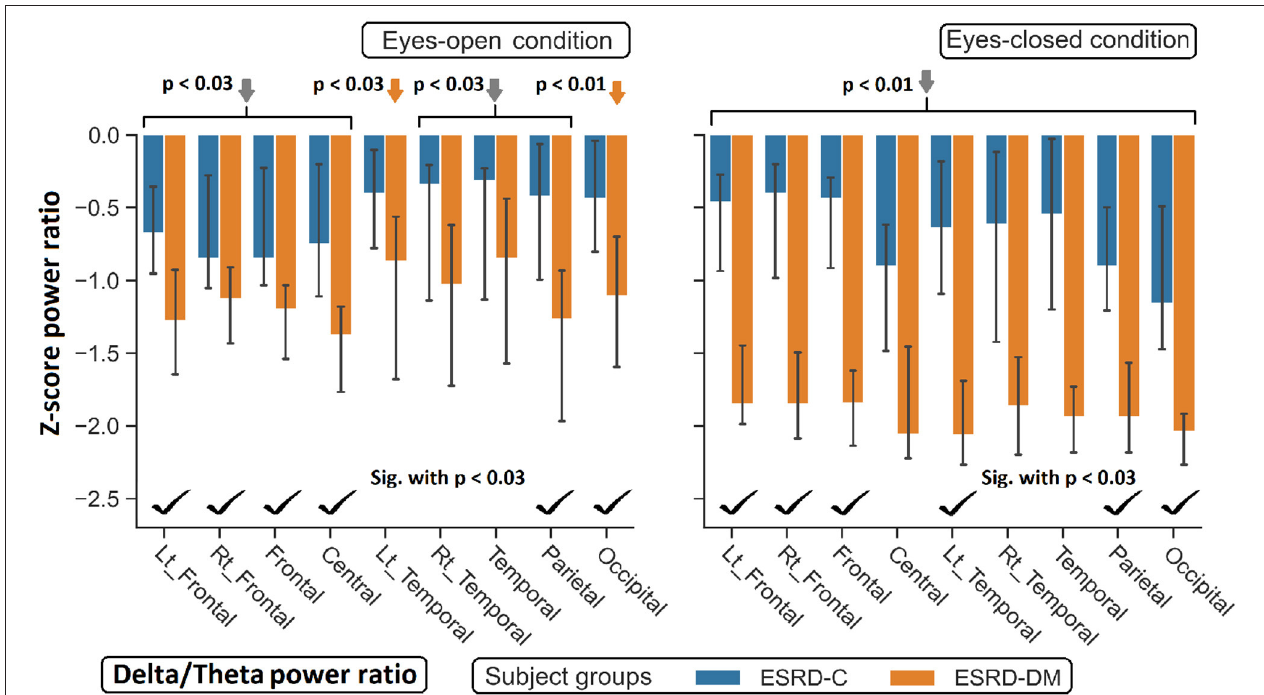
FIGURE 8 | Z-scores of the delta/theta power ratio in most regions between ESRD-C and ESRD-DM were significantly different as signified by check mark. Delta/theta ratio in ESRD-DM globally decreased from healthy control (orange arrows). The same trend was found in ESRD-C. P -values were calculated by Mann–Whitney U -test. The whisker indicates 95 percent confident intervals with median as an estimator. Gray arrows refer to significant deviation from healthy control in both subject